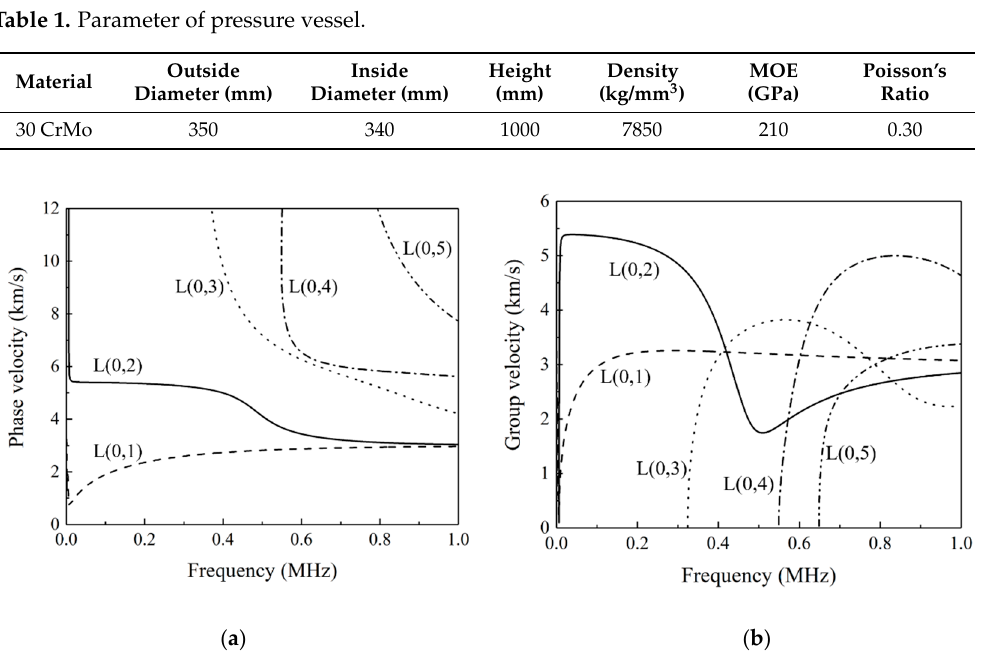
Figure 7. Amplitude–frequency characteristics of L (0,1) and L (0,2) modes.